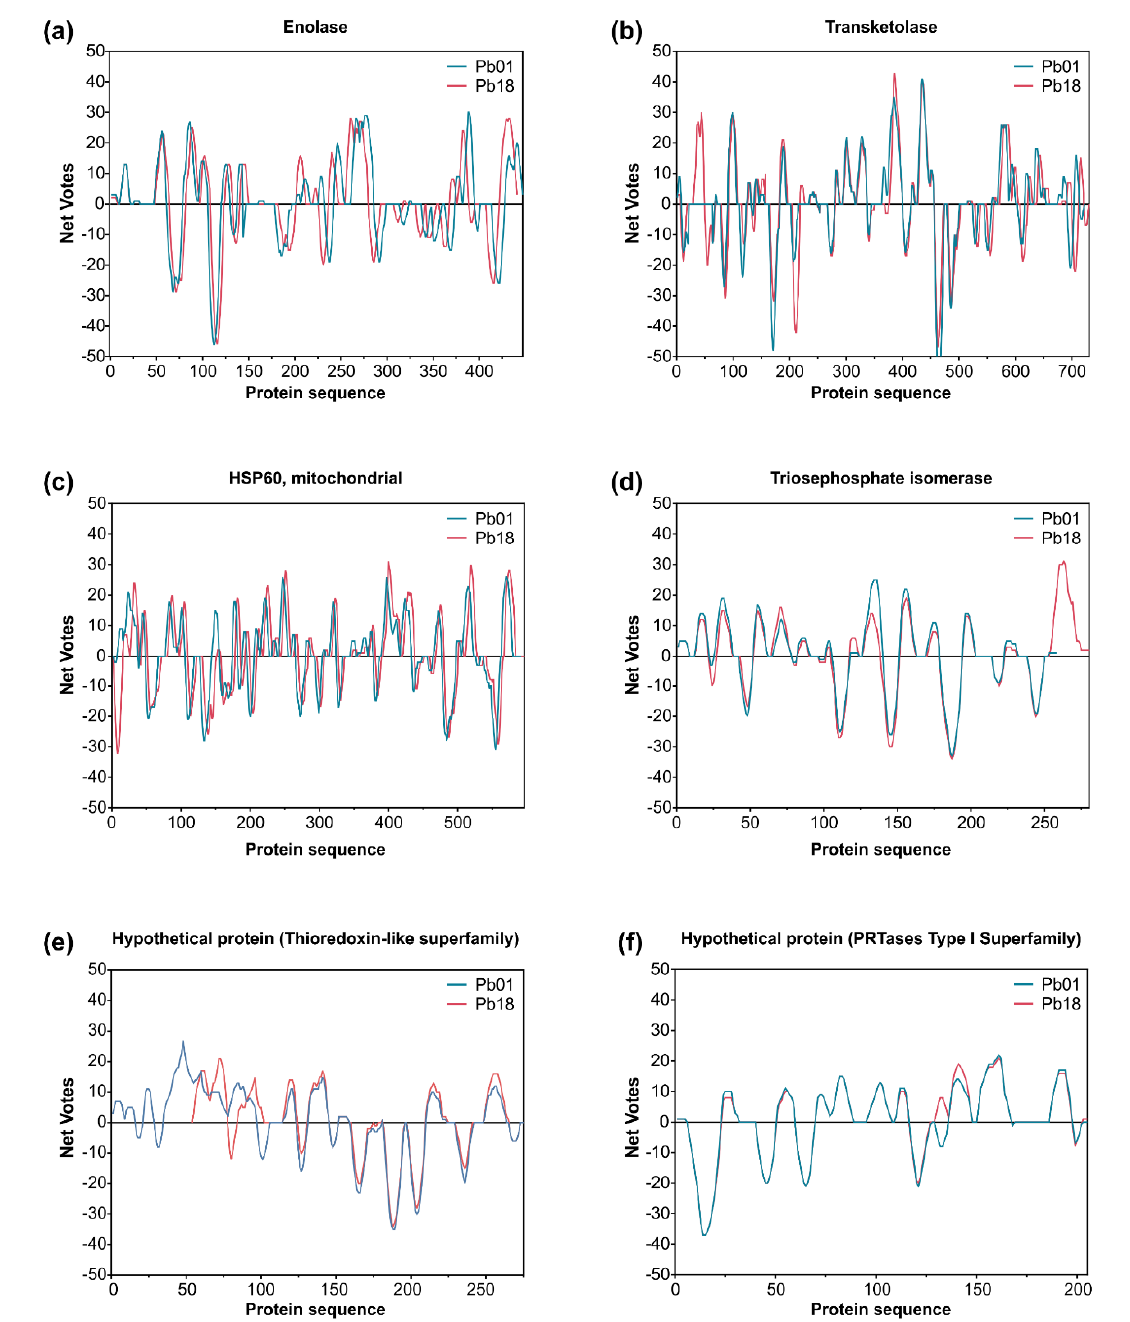
Figure 6. Immunoreactive proteins found in the P. lutzii immunoproteome with the highest antigenic scores. Residue epitope propensity score predictions for ( a ) enolase (XP_015703472 and XP_010759701), ( b ) transketolase (XP_002793534 and XP_010760067), ( c ) heat shock protein 60, mitochondrial (XP_002789992 and XP_010763632), ( d ) triosephosphate isomerase (XP_002795879 and XP_010762134), ( e ) uncharacterized protein—Thioredoxin-like superfamily (XP_015700719 and XP_010758121), and ( f ) uncharacterized protein—PRTases type I superfamily (XP_015701261 and XP_010756299). The antigenic propensity scores are plotted against position along the amino acid sequence as predicted by the COBEpro algorithm [82]. The higher the antigenic propensity scores, the more likely is the antigenic activity for the respective region. COBEpro uses a support vector machine to assign epitope propensity scores to peptide fragments.